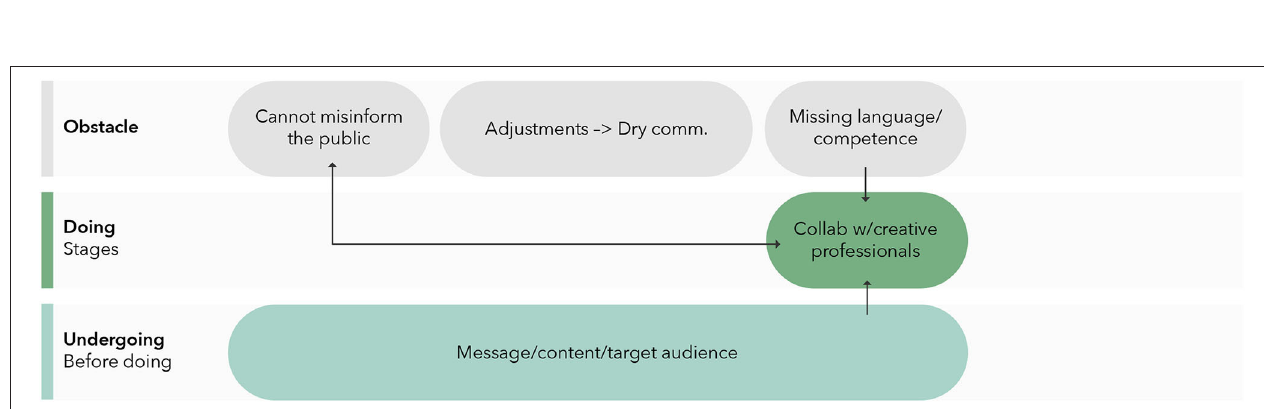
FIGURE 2 | A flow chart representation of creative activity as explained by health